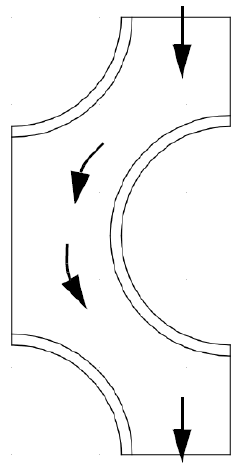
Figure 15. The modeled two dimensional region cross section of the tube and the channel. The arrows presented in Figure 16 indicate the flow direction the Heptane combustion products.